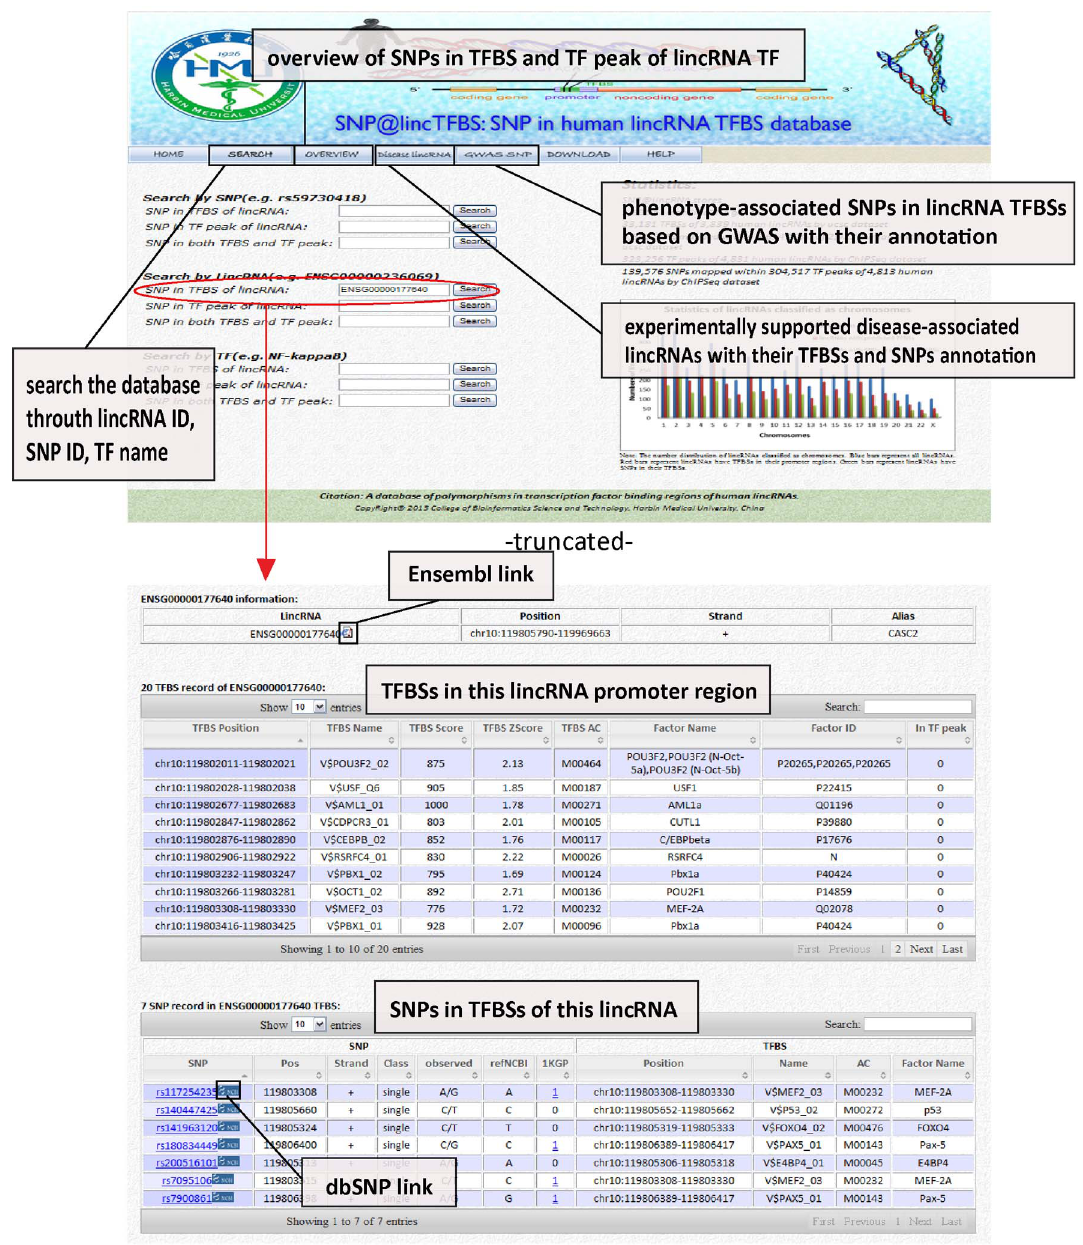
Figure 3. The homepage and an example of SNP@lincTFBS database. Screenshot of the main search page and corresponding result page, search as lincRNA ENSG00000177640.